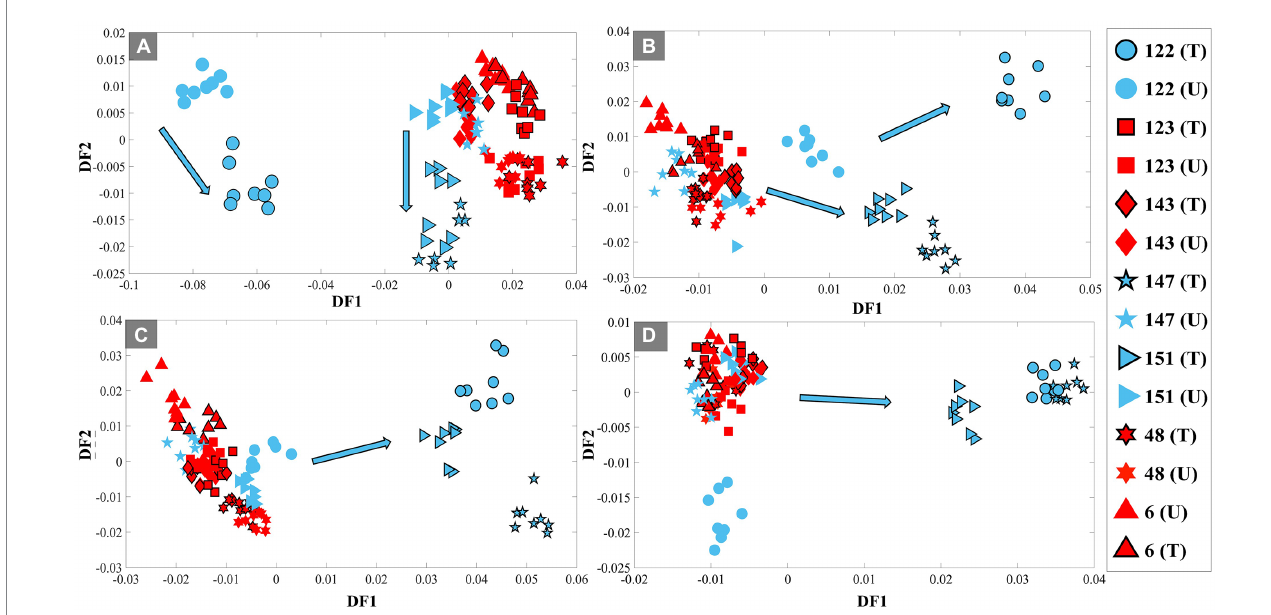
FIGURE 1 PC-DFA scores plots of pre-processed FT-IR spectral data (4,000–2,000 cm − 1 ) of the UPEC isolates grown in LB broth containing 80% D 2 O, with (10 mg/l TMP) and without TMP at 4 different time points of 1 h (A) , 2 h (B) , 3 h (C) and 4 h (D) . TMP-susceptible isolates are shown in blue, while TMP-resistant isolates are shown in red. The black outline represents the TMP-treated (T) condition, while those without it represent the untreated (U) condition (control group). UPEC isolates investigated in this study are represented by different numbers and symbols. Blue arrows indicate the trend detected for the treated TMP- susceptible